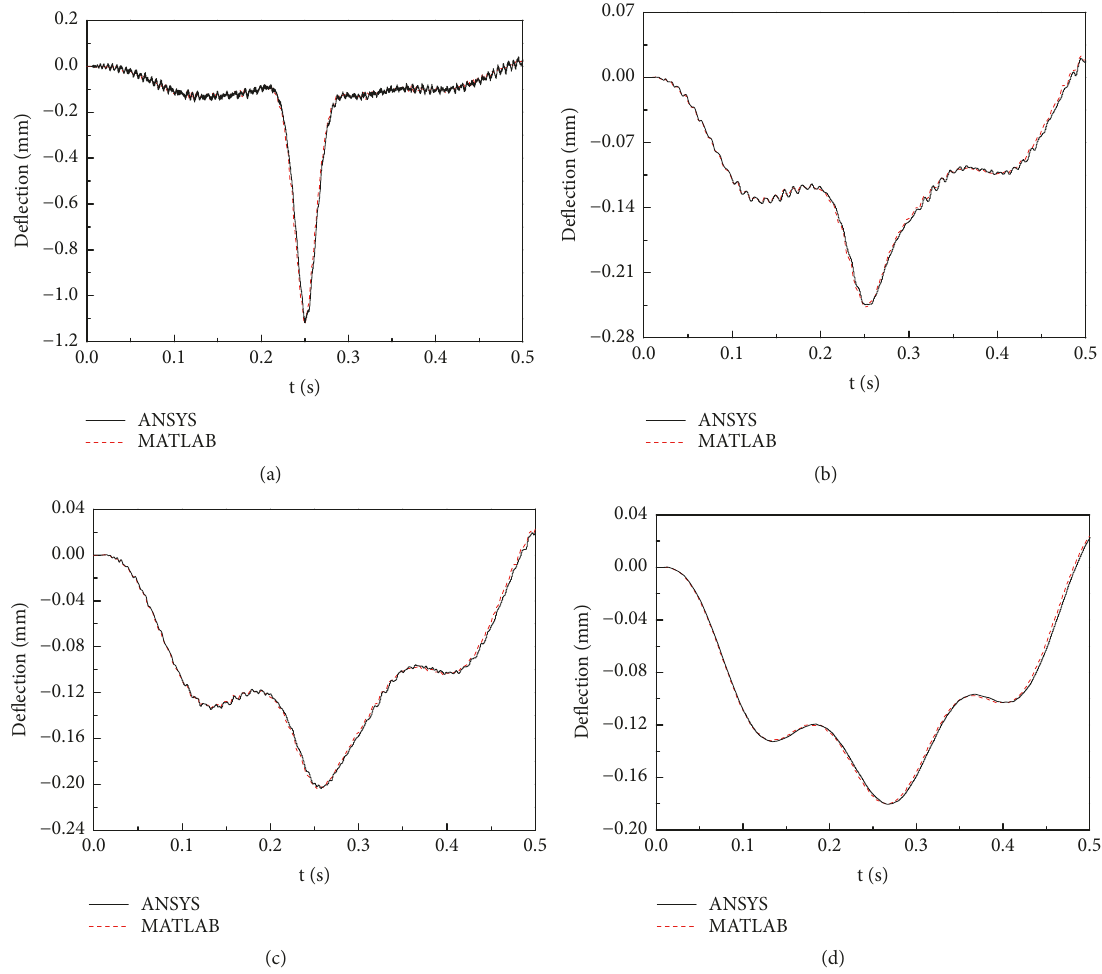
Figure 6: Mid-span deflection time-history for quadruple simply supported beam system with load moving speed v = 64 m/s: (a) first beam; (b) second beam; (c) third beam; (d) fourth beam.